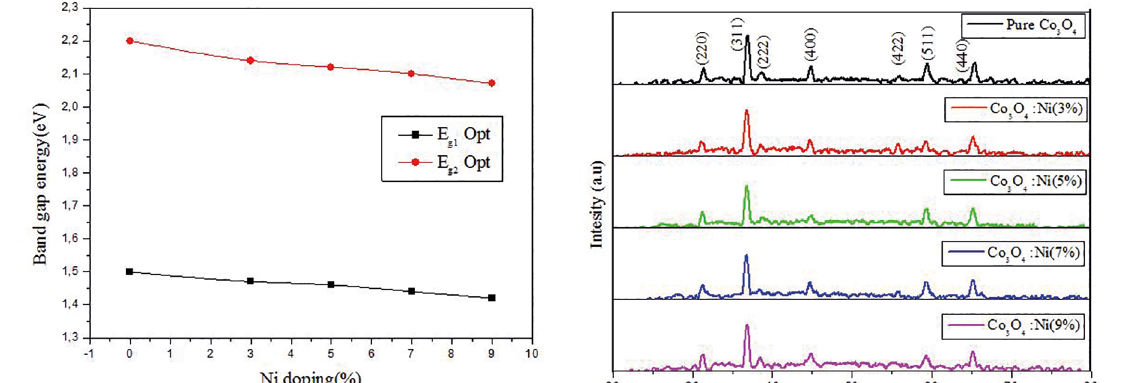
Figure 5. Variation of the optical gap of Ni-doped Co different doping levels Figure 6. XRD patterns of pure and Ni-doped Co